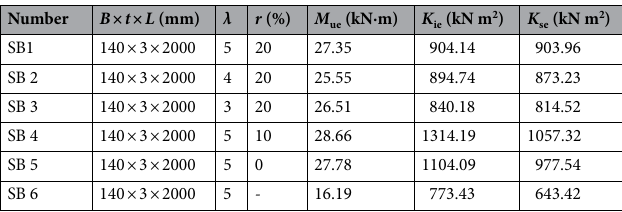
Table 1. Parameters of specimens.